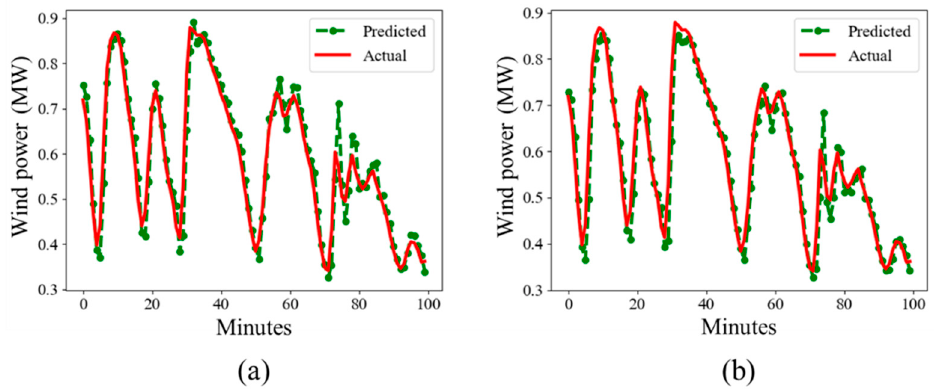
Figure 8. Visual results on wind data having a 5 min resolution, where ( a ) is the ED prediction graph, while ( b ) is the AB-Net model prediction graph for wind power in MW.